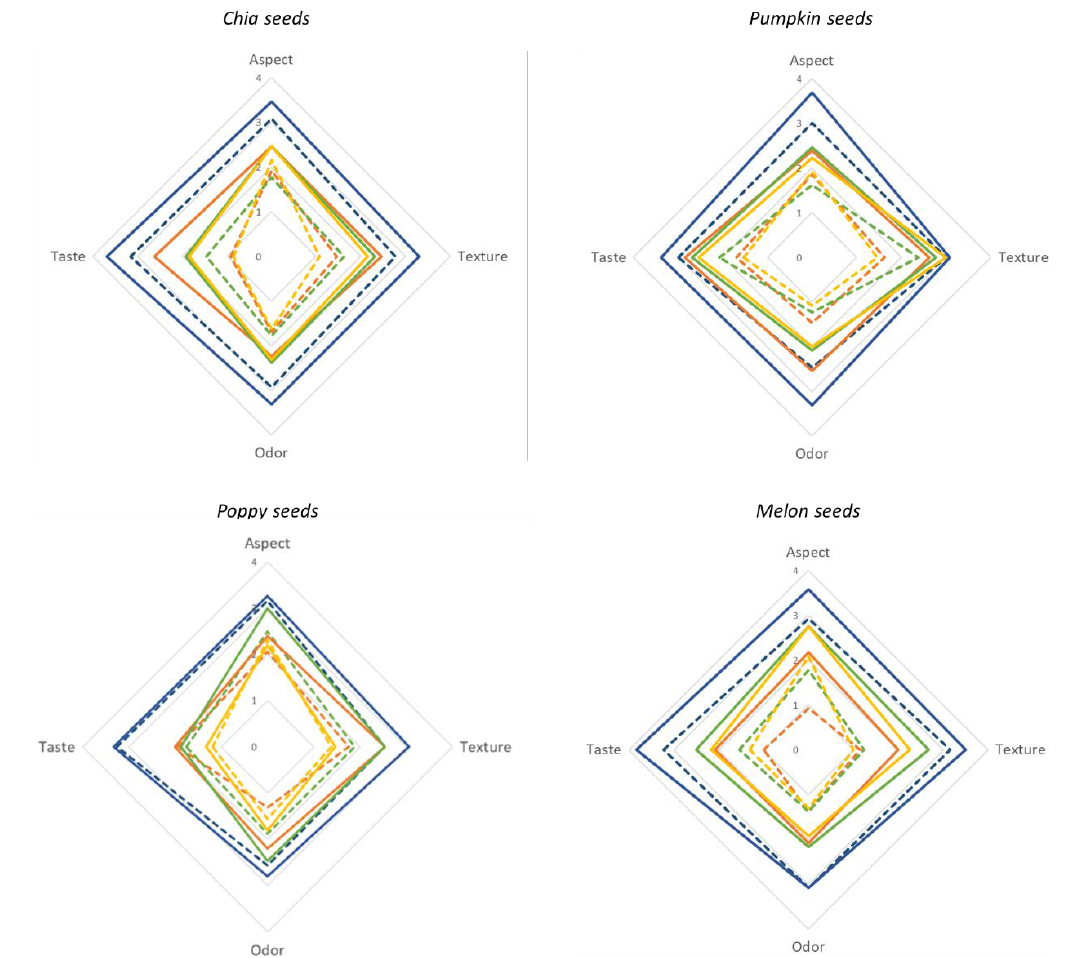
Figure 3. Radar charts for the sensory evaluation of segmented consumers (neophobic and non- neophobic consumers). Solid lines indicate the values of non-neophobic consumers for the proposed attributes and dotted lines values for neophobic consumers. Blue lines indicate the evaluation of the control sample, orange lines the 50% replacement, green lines 75% replacement and yellow lines 100% replacement. The consumers evaluated the physical aspect, texture, odor, and taste using a 9- point scale ( – 4: extremely dislike; 0: neither like nor dislike; +4: like extremely).